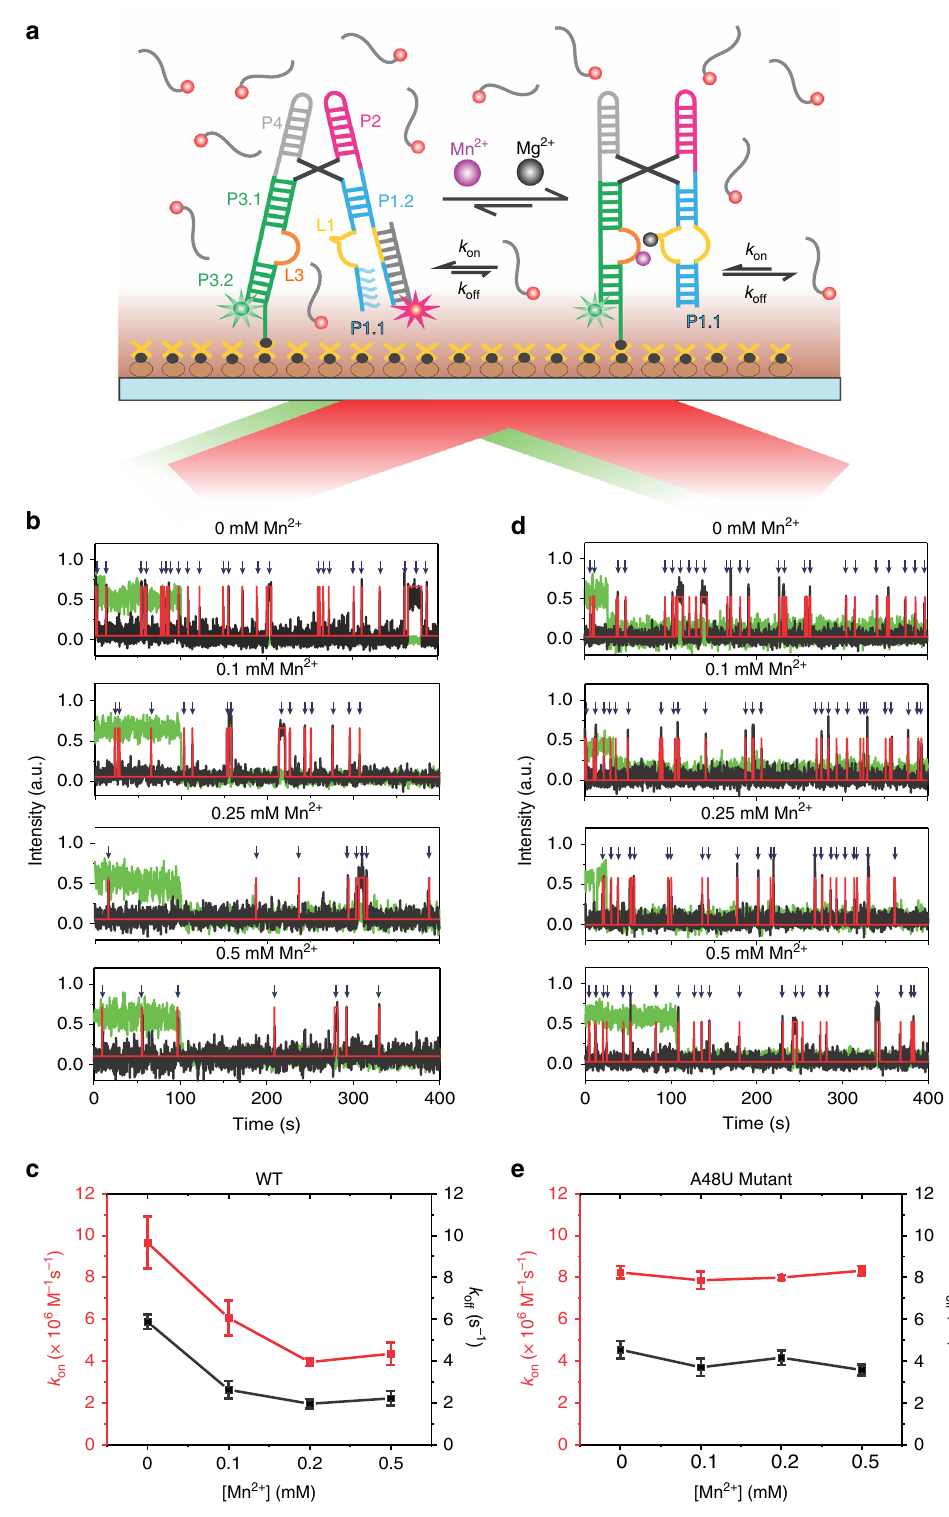
Fig. 7 Accessibility of switch helix P1.1 probed using a SiM-KARTS assay. a Schematic of our SiM-KARTS assay to probe the accessibility of switch helix P1.1 in the presence and absence of Mn 2 + . b Representative SiM-KARTS traces at different Mn 2 + concentrations show multiple binding events of the Cy5- labeled DNA oligonucleotide probe. Green, Cy3 intensity; black, Cy5 intensity; red, idealized Cy5 intensity fi t to a two-state model. c The association ( k on , red) and dissociation ( k off , black) rate constants for binding of probe to P1.1 as a function of Mn 2 + concentration for the WT riboswitch. The errors for the rate-constants are obtained using a boot-strapping program, as described in Methods. d , e Same as in ( b ) and ( c ), but for the A41U mutant riboswitch. Over 200 traces were analyzed for each condition to obtain reliable kinetic rate constants. The data for kinetic plots in ( c ) and ( e ) are provided in the Source Data fi